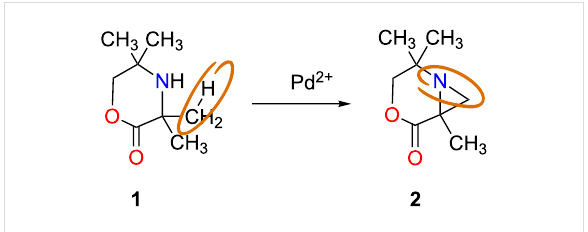
the observed experimental data and to predict process perfor- mance under unseen conditions. Thus, experiments required for model development are frequently what would be considered as ‘bad’ experiments in the case of